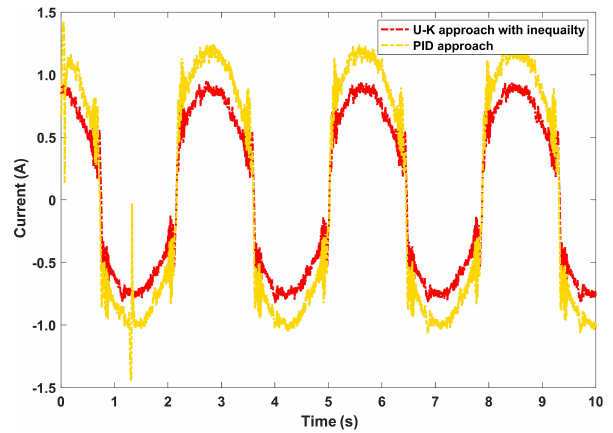
Figure 18. The control input of the steady-state performance of the U–K inequality constraint and